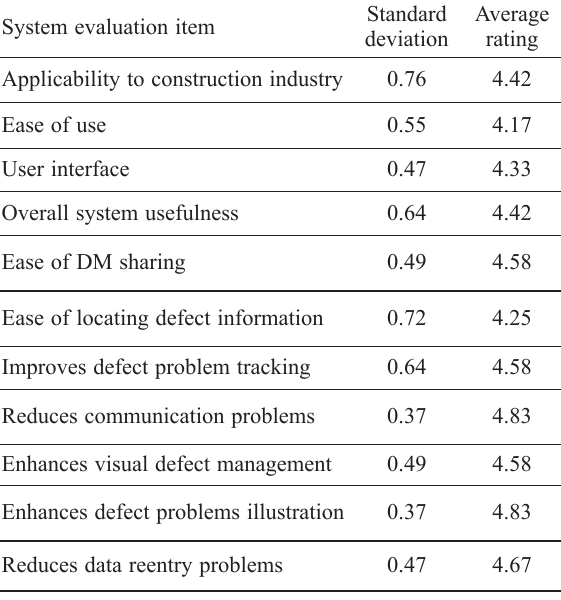
Table 3. System evaluation